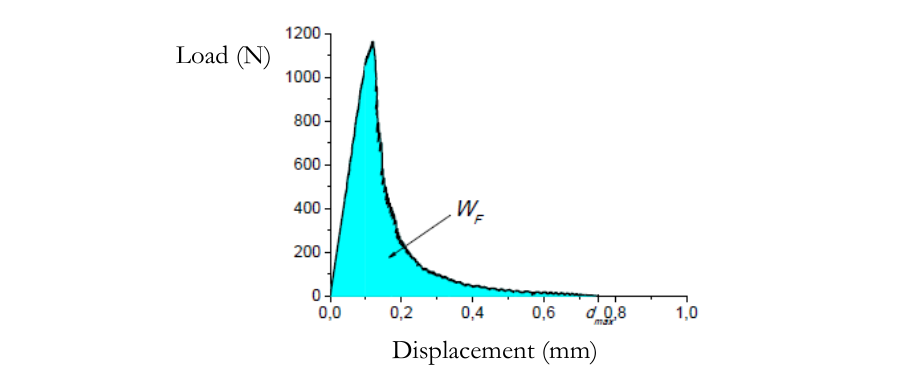
Figure 1: Load-displacement curve of concrete